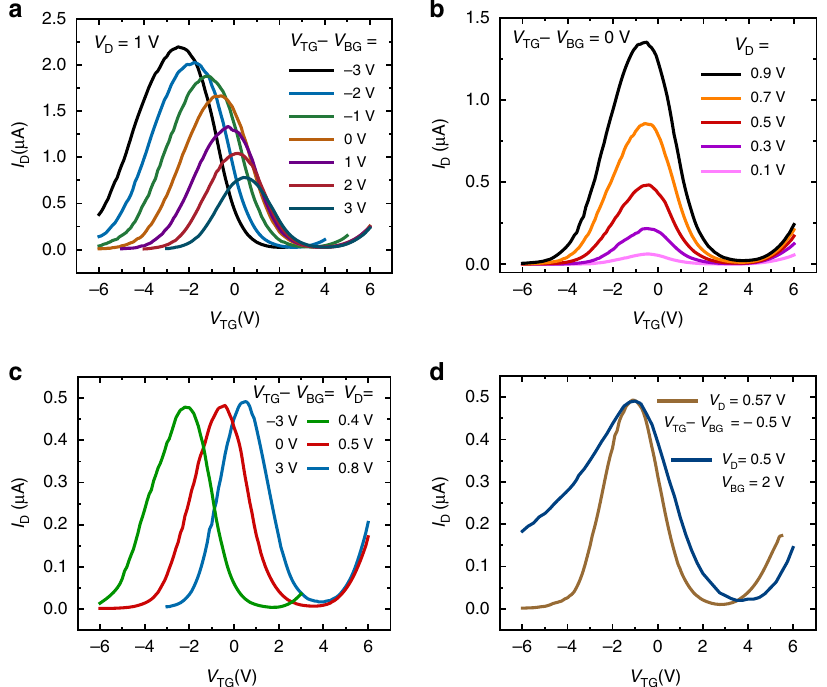
Fig. 3 Dependent gate operation of Gaussian heterojunction transistors. a I D – V TG for simultaneous sweeping of V BG with V TG with controlled offsets, showing control of both sides of the antiambipolar response and of the peak position. b I D – V TG for varied V D , showing that the height of the Gaussian transfer response can be controlled while maintaining the peak position. c I D – V TG for changing V D and V TG – V BG , indicating that the peak position can be controlled while maintaining the height of the Gaussian transfer response. d I D – V TG comparing dependent and independent gate biasing with an adjusted V D , showing modulation of the FWHM of the Gaussian transfer response while maintaining the height and peak position. All measurements were performed in ambient at room temperature with V S = 0